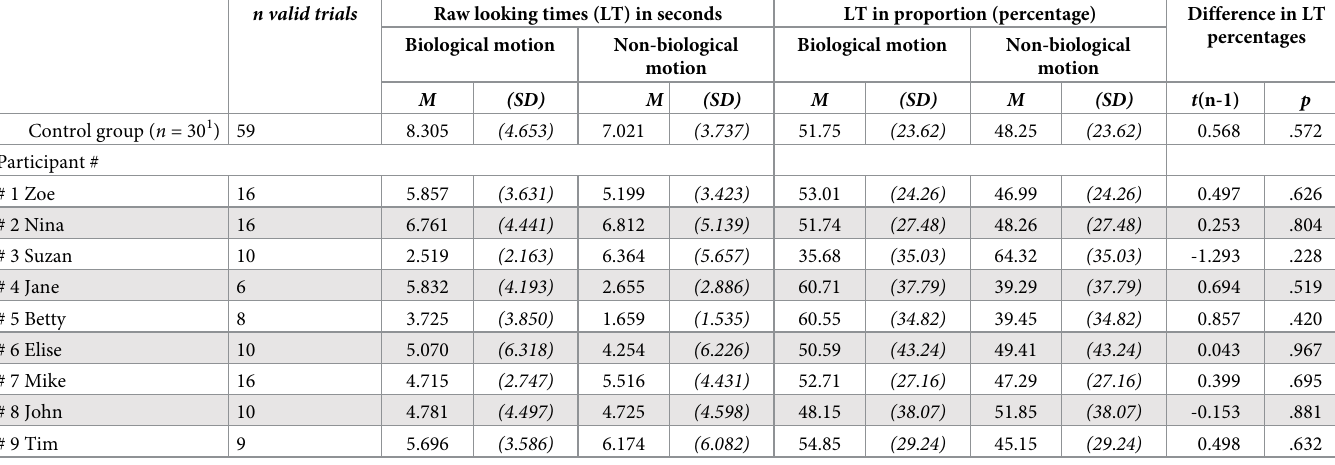
Table 5. Mean (and SD ) looking times (raw and percentage) at each of the two stimuli of the PL-Task (i.e., biological vs. non biological motion), consisting of two 20-second trials, of the control group and the nine PIMD participants. n valid trials